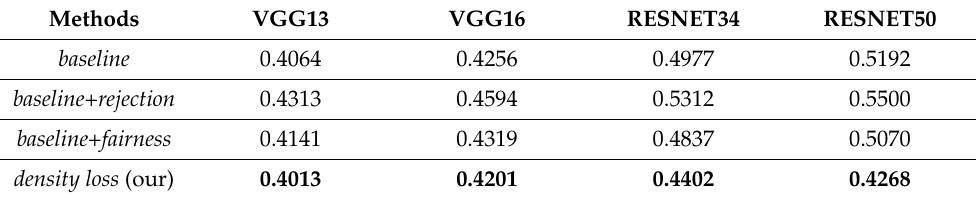
Table 6. Average distance (see Sections 3.1 and 3.2.2) between true and predicted size distribution of objects of interest for different methods and backbones on PASCAL VOC